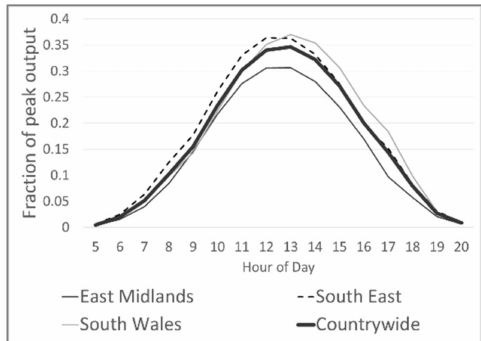
Figure 13. Average fraction of peak output per hour (2005–2014).